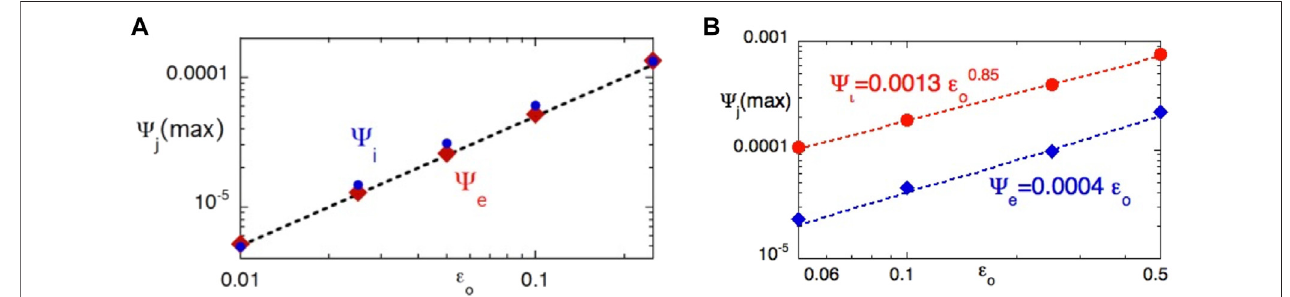
FIGURE5| SimplescalingrelationsderivedfromPICsimulations[92]. (A) Themaximumvaluesofthedimensionlesstimeratesofchangeoftheelectron(bluedots) and ion (red diamonds) entropies derived from the whistler turbulence PIC simulations of [56]. The scaling relations derived for whistler turbulence are: the maximum entropy increase for electron: Ψ e ≃ 0 . 0005 E 0 ; the maximum entropy increase for ion: Ψ i ≃ 0 . 0005 E 0 (B) The maximum positive values ofthe dimensionless time ratesof change of the electron (blue boxes) and the ion (red dots) entropies of the kinetic Alfvén PIC simulations of [47]. The scaling relations derived for kinetic Alfven turbulence are: the maximum entropy increase for electron: Ψ e ≃ 0 . 0004 E 0 ; the maximum entropy increase for ion: Ψ i ≃ 0 . 0013 E 0 . 85 0